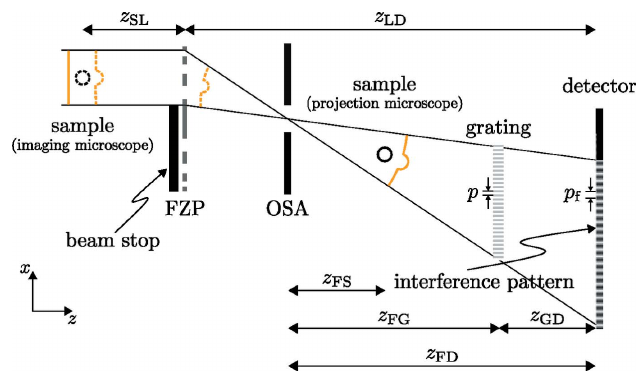
Figure 1 Schematic of the setup. The X-rays enter from the left and are focused by a partially covered Fresnel zone plate (FZP). An order sorting aperture (OSA) is positioned in the back focal plane of the FZP in order to minimize the impact of higher diffraction orders from the FZP. The grating with period p is placed in the divergent beam such that a magnified self-image with fringe period p f occurs in the detection plane. The sample can be either placed downstream of the focus, corresponding to a projection microscope and suggested by the solid circle, or in a conjugate plane upstream of the FZP as implied by the dashed circle, resulting in an imaging microscope. Specific distances of the setup, as they are introduced in the main text, are